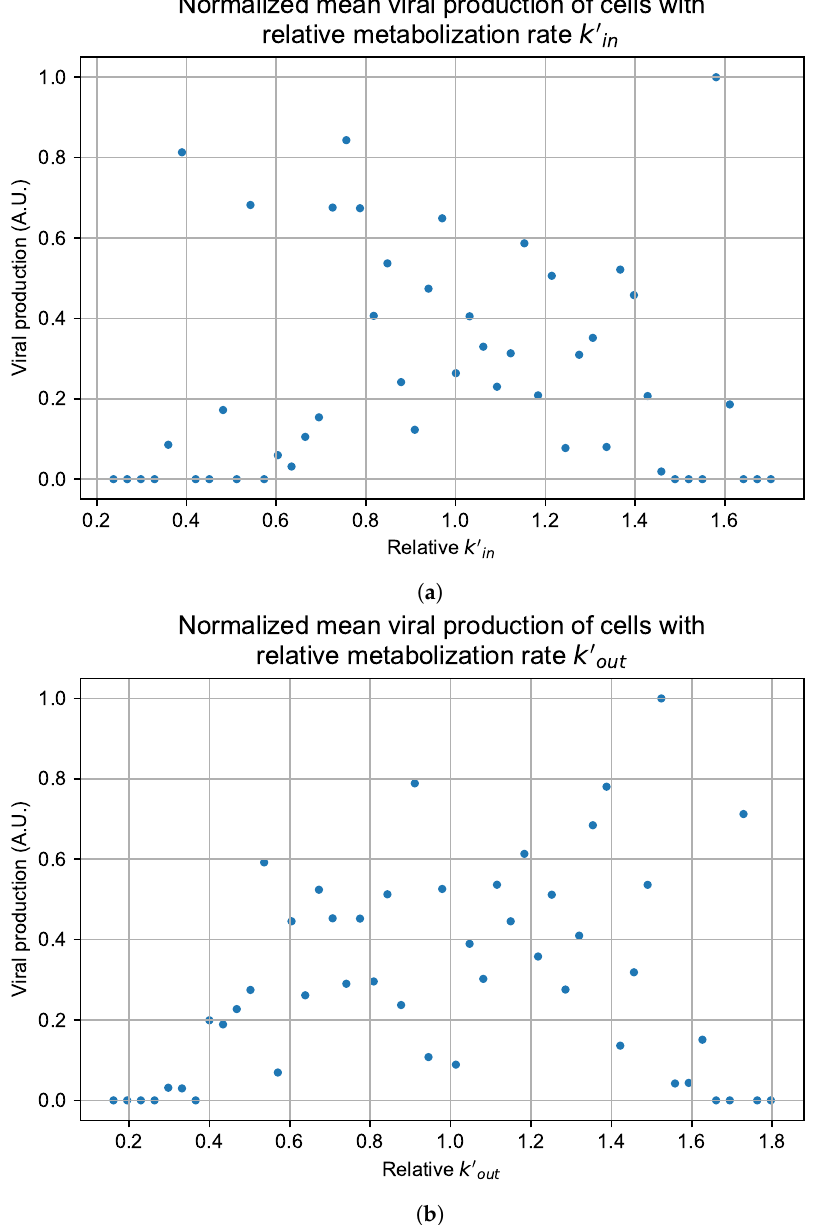
Figure A124. Mean viral production of cells versus their metabolism rates normalized by the maxi- mum mean production with rapid clearance parameters. ( a ) Results for simulations varying only k in . ( b ) Results for simulations varying only k out